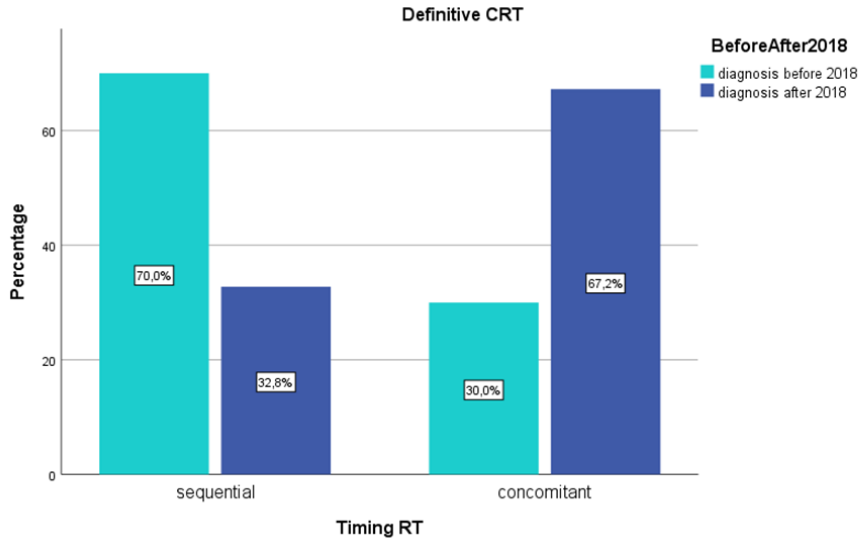
Figure 2. Bar graphs of therapeutic pathways before and after 2018. CRT, chemo-radiation therapy.